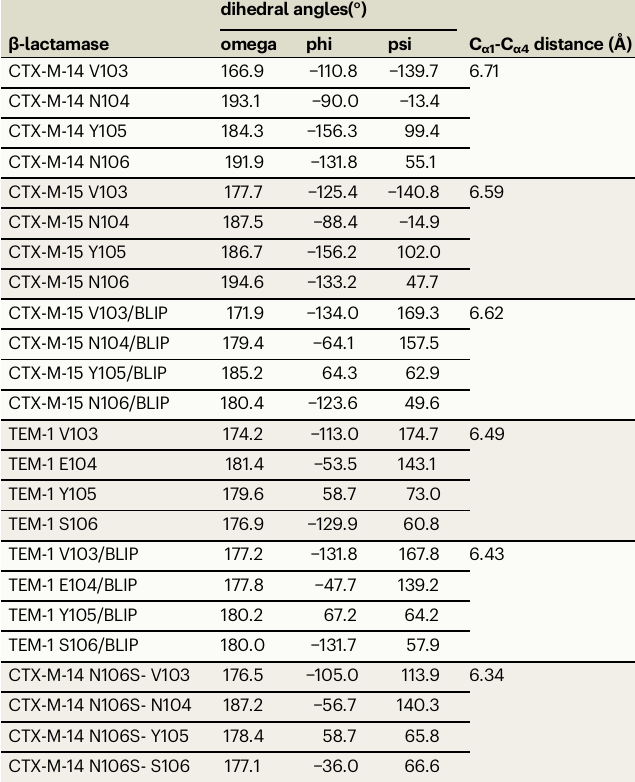
Table 2 | Dihedral angles of β -lactamase residues 103 –